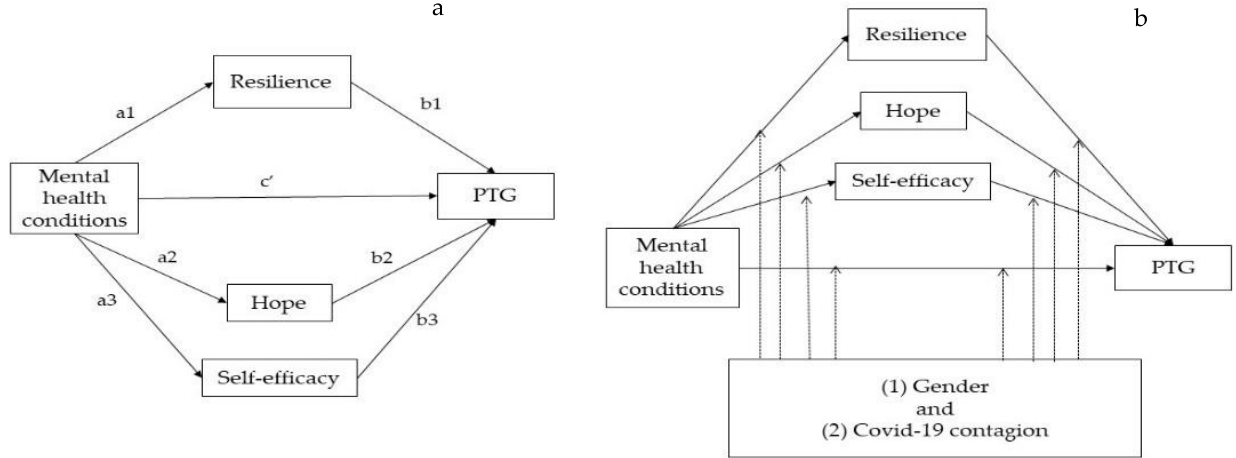
Figure 1. ( a ) Hypothesized mediation model explaining the potential mediating effect of resilience, hope and self-efficacy on the relationship between each of level of anxiety, depression and stress, and post-traumatic growth; ( b ) Model of the potential moderating effects on the paths. PTG: post- traumatic growth.